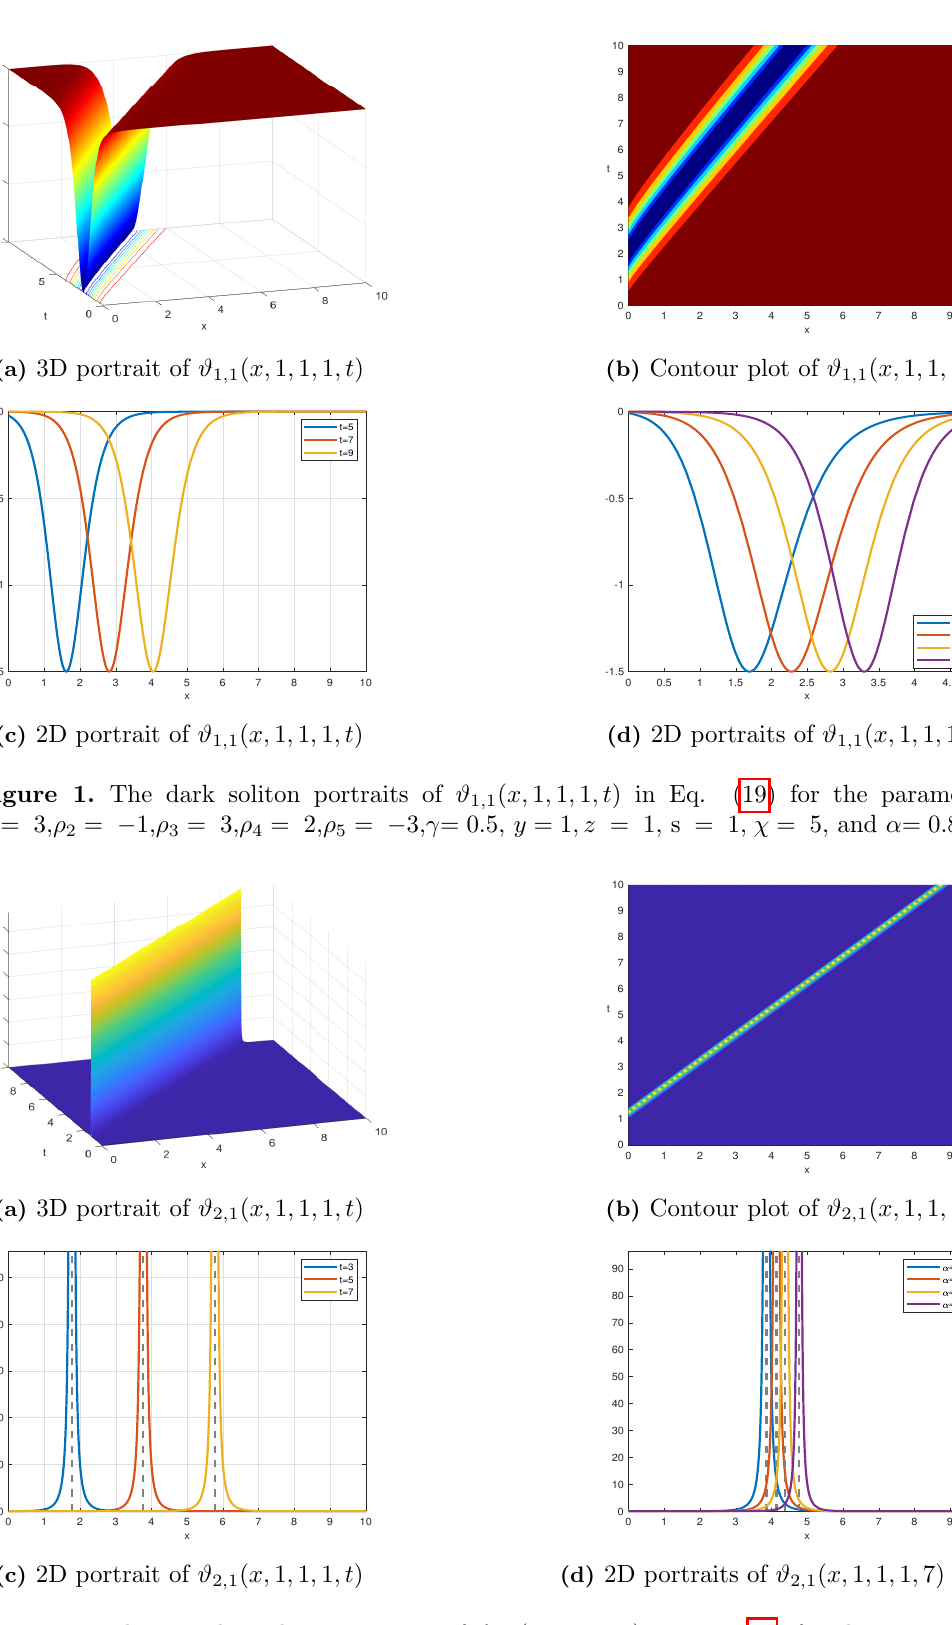
Figure 2. The singular soliton portraits of ϑ 2 , 1 ( x, 1 , 1 , 1 , t ) in Eq. (23) for the parameters ρ 1 = 3 , ρ 2 = − 1 , ρ 3 = 3 , ρ 4 = 2 , ρ 5 = − 3 , γ = 0 . 5 , y = 1 , z = 1 , s = 1 , χ = − 5 , and α =